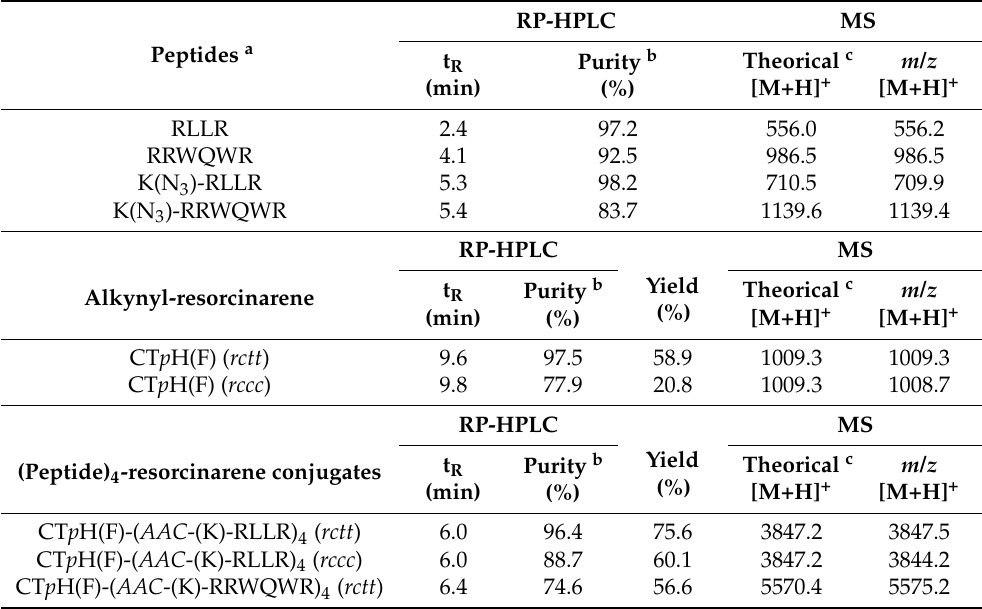
Table 1. Peptide, alkynyl-resorcinarenes precursors, and synthesized conjugates. RP-HPLC and MS characterization